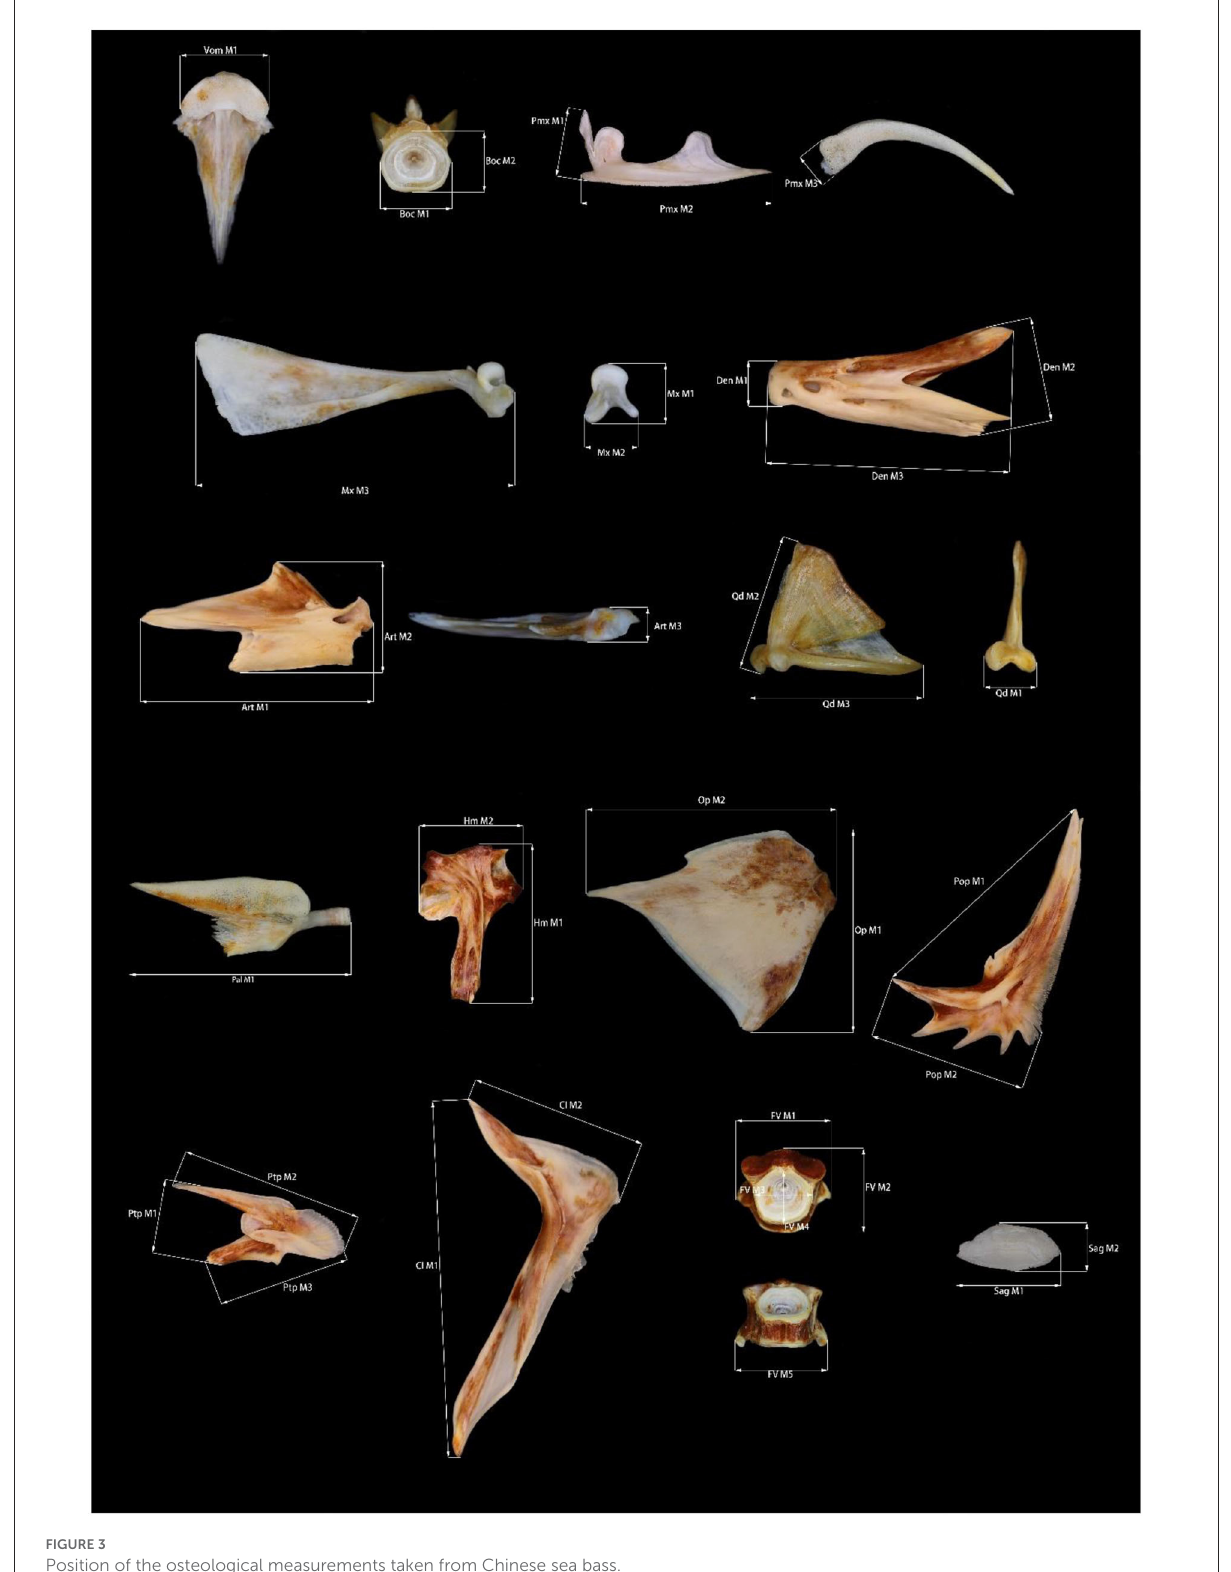
FIGURE3 Position of the osteological measurements taken from Chinese sea